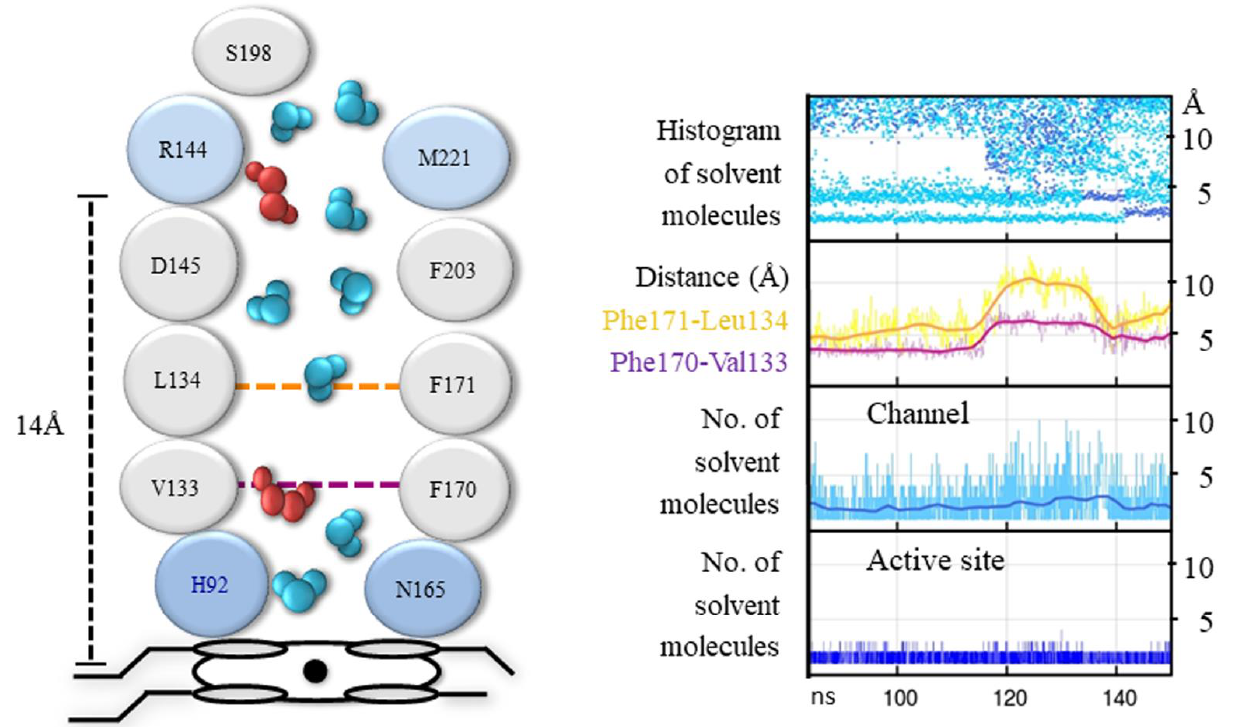
Figure 8. Detection of a gate valve mechanism at the FS of the main channel in CAT-1. Left: shown is a scheme of the FS, from the Fe of the heme to the gate (Ser198), a distance of ~17 Å. The circles represent the amino acid residues that line the FS, which is filled with water (blue) and H 2 O 2 (red) molecules. Phe171 and Phe170 are very mobile residues opposite to Leu134 and Val133, respectively. Shown in blue are the R144/M221 low affinity binding site for H 2 O 2 and the H192/N165 high affinity active site. Right: measurements from MD simulations [66], reprinted with permission a modified Figure 6D from ref. [47] 2014, Wiley). From top to bottom: the presence of solvent molecules along the 14 Å length channel (water = light blue, H 2 O 2 = dark blue); the distance between the Phe171 and Leu134 (yellow) and the Phe170 and Val133 (magenta); the number of solvent molecules in the FS; and the number of solvent molecules at the active site His92/Asn165. Shown as a time lapse for the MD simulation (~65 ns) in which at the beginning both phenylalanine residues are very close to their opposite amino acid residues, closing the FS and thus no solvent molecules were detected in a region of ~6 Å in the FS. Then, both Phe residues are seen to rotate simultaneously, away from their opposite residues, thereby opening the FS and allowing the entrance of solvent molecules into the empty gap. A mean of five solvent molecules enters but only three reach the active site. The water molecule at the His92 is substituted by H 2 O 2 .